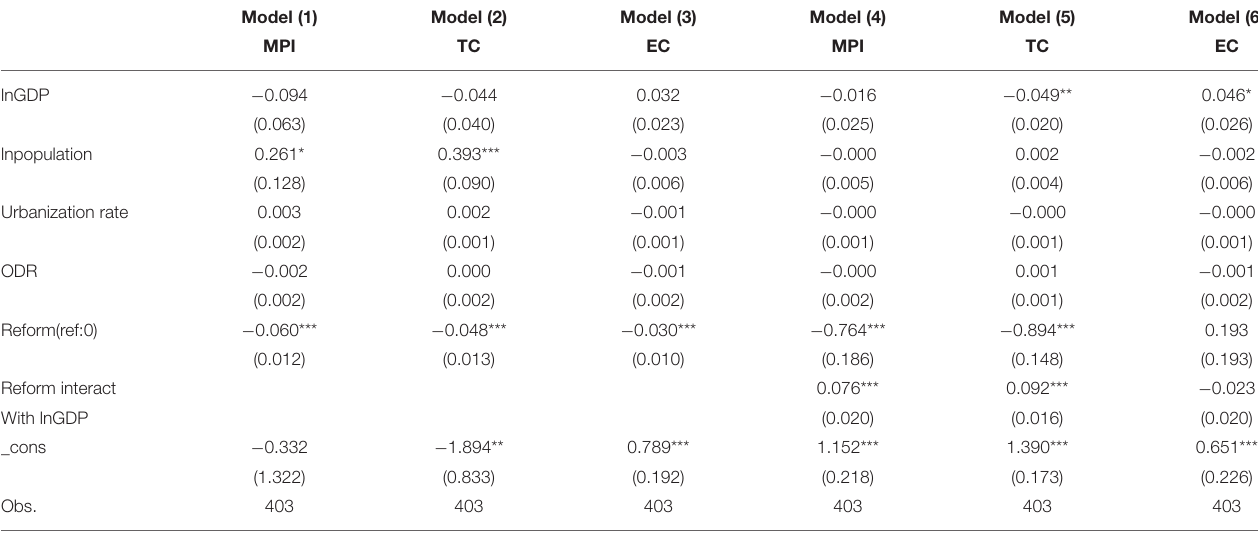
TABLE 4 | The impact of reform and external factors on the efficiency of